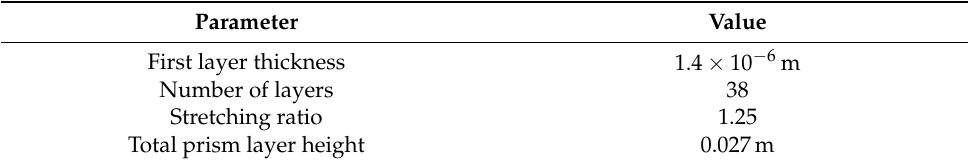
Table 3. Parameters of prism layer.